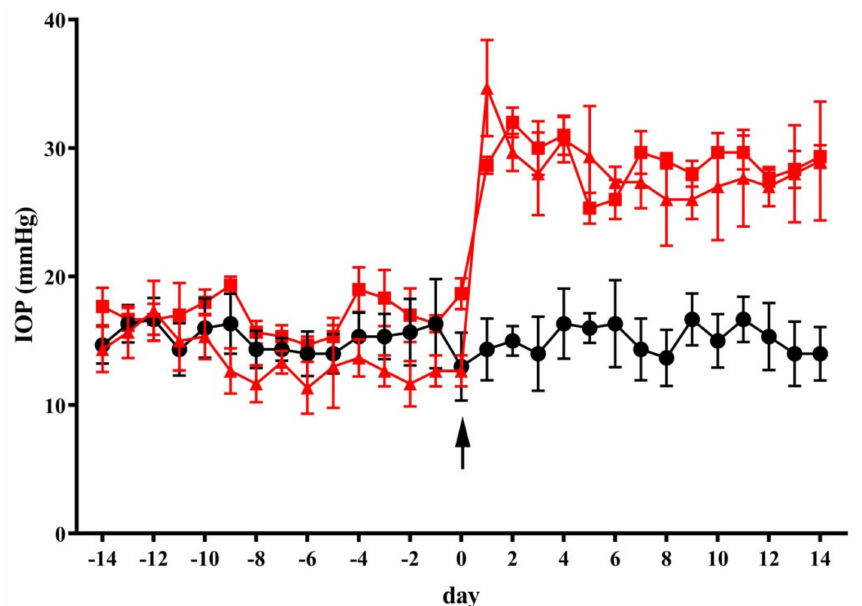
Figure 1. Dietary supplementation did not a ff ect intraocular pressure (IOP). The injection of methylcellulose (MCE) in the anterior chamber at day 0 (arrow) resulted in a significant elevation in the intraocular pressure. Both the vehicle and diet supplement did not a ff ect IOP in mice receiving MCE. Data are shown as mean ± SEM ( n = 11 for each group). Black circles and line: control mice; red squares and line: mice intraocularly injected with MCE fed with vehicle; red triangles and line: mice intraocularly injected with MCE fed with diet